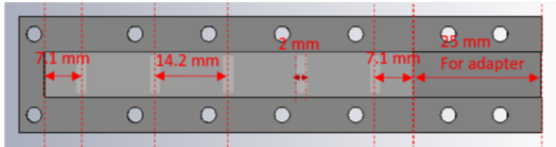
Figure 2. Interior of the feeding waveguide.